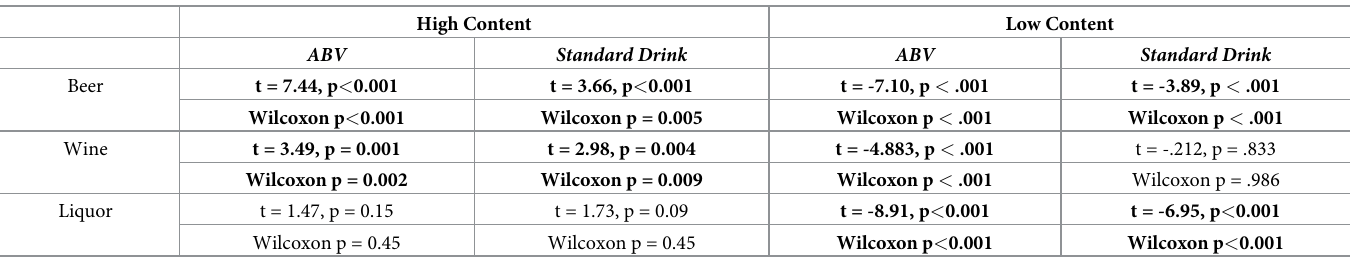
Table 5. Single sample t-tests and Wilcoxon signed rank